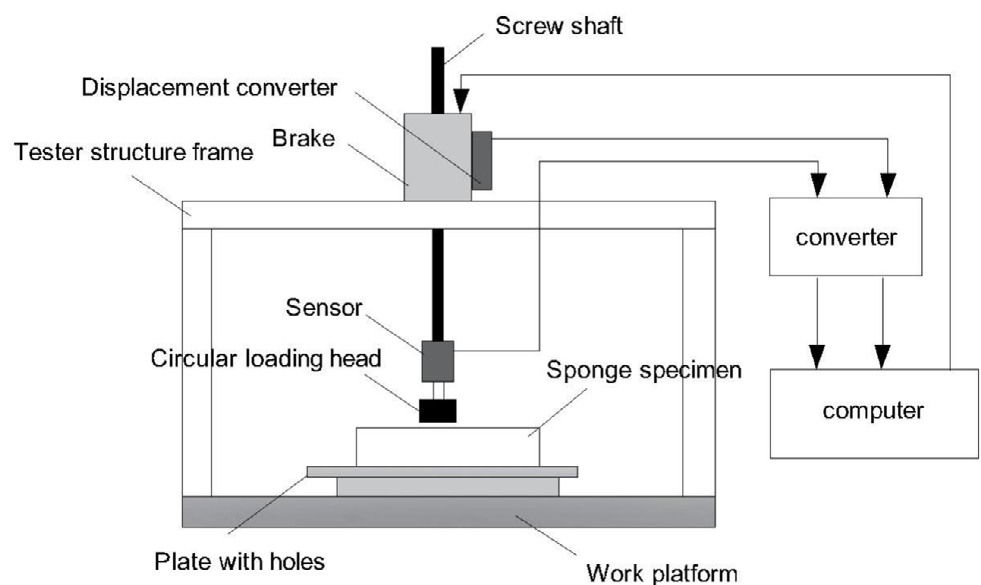
Figure 3. The vertical loading system.